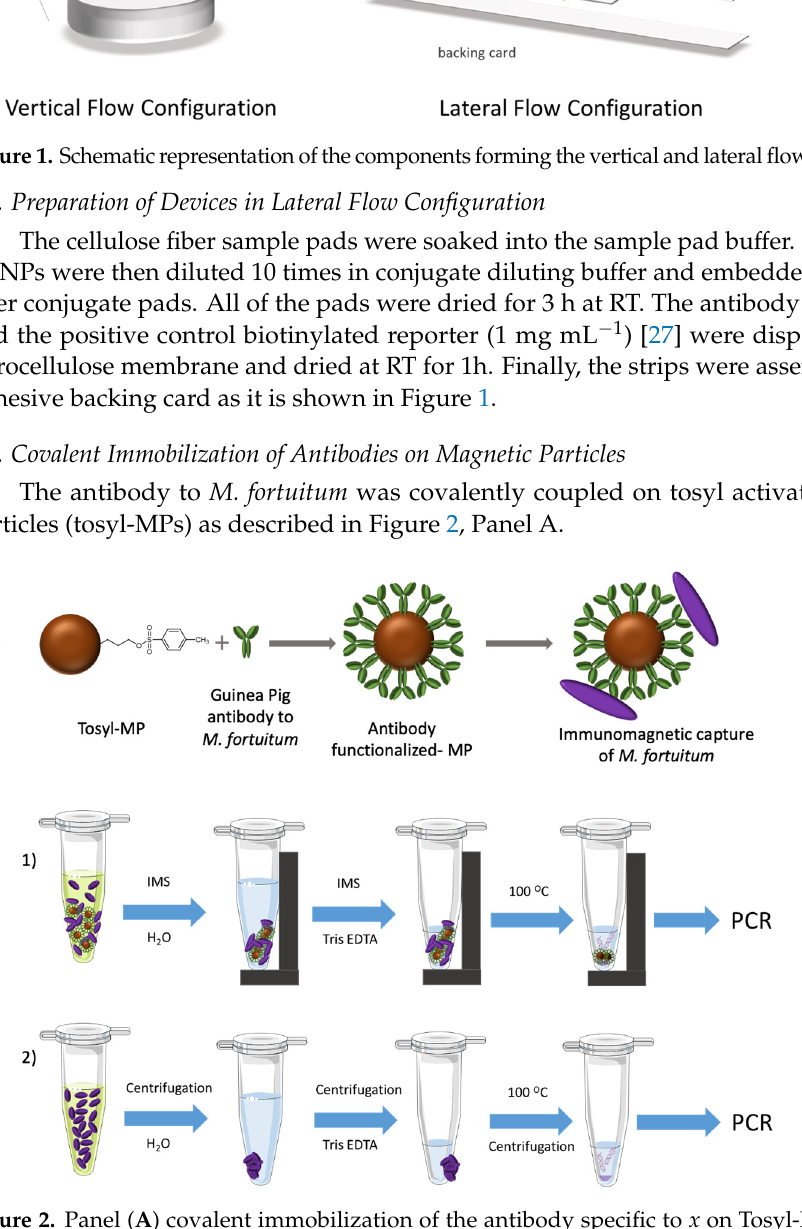
Figure 2. Panel ( A ) covalent immobilization of the antibody specific to x on Tosyl-MP. Panel ( B1 ) schematic procedure for the DNA extraction performed after immunomagnetic separation and magnetic preconcentration of M. fortuitum . Panel ( B2 ) schematic procedure for the DNA extraction performed from culture media dilutions.